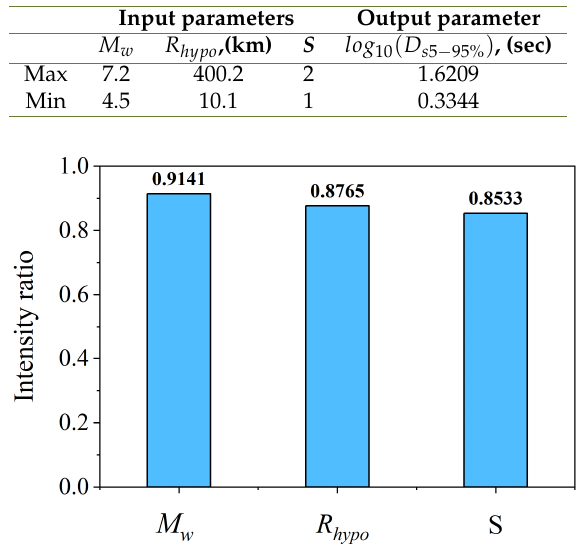
Table 3. Limit of parameters used in this study.